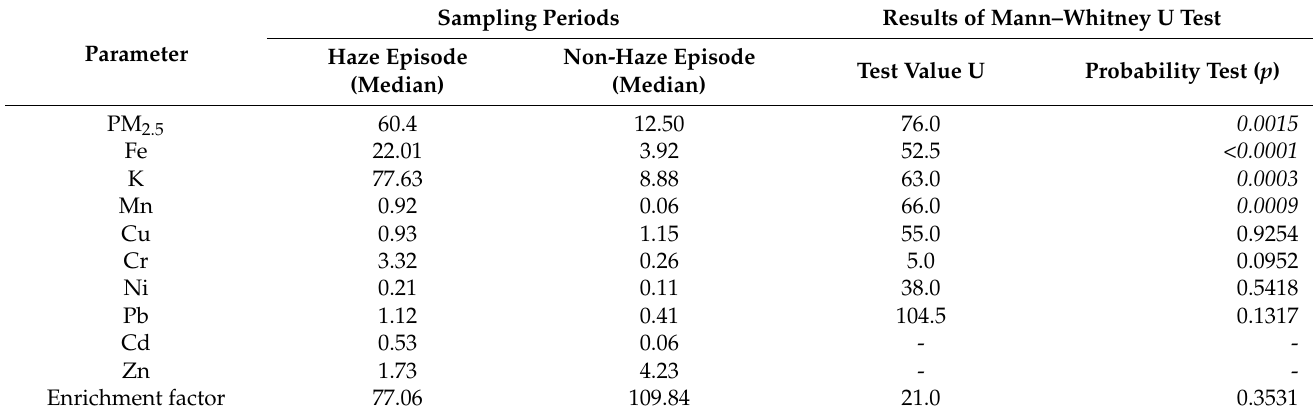
Table 3. Comparison of the element indices values between haze episode and non-haze episode using the Mann–Whitney U test.